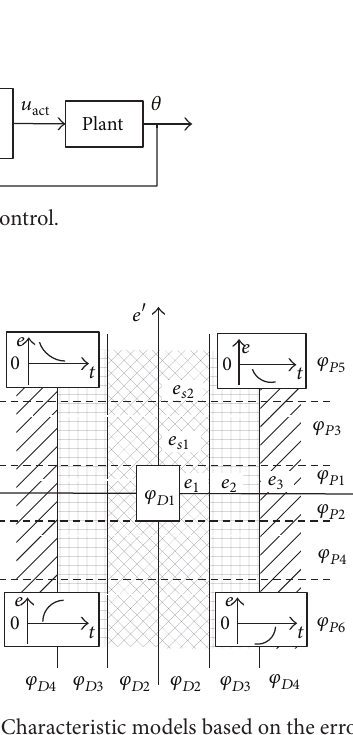
Figure 3: Characteristic models based on the error